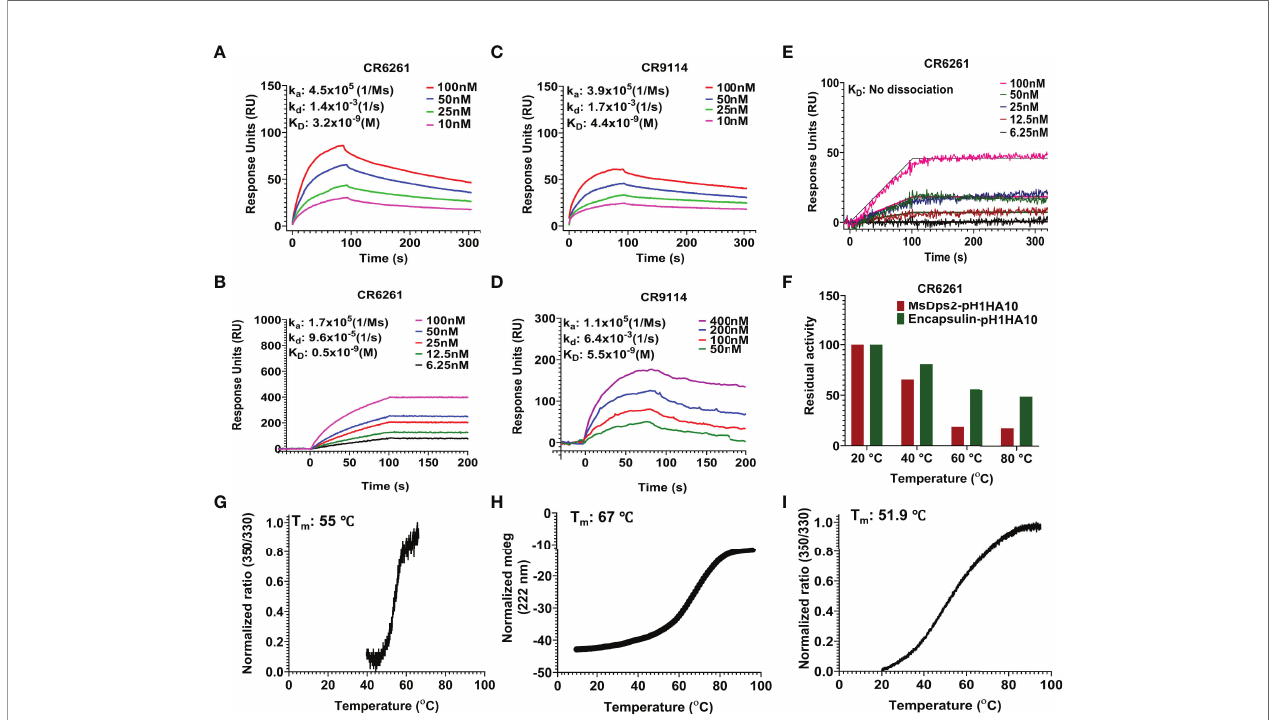
FIGURE 3 | SPR studies and thermal stability of pH1HA10-nanoparticle immunogens. (A – D) SPR binding studies of MsDps2-pH1HA10 (top) and Encapsulin- pH1HA10 (bottom) with CR6261 (A, B) or CR9114 (C, D) . (E) SPR binding of pH1HA10-Ferritin with CR6261. (F) Thermal tolerance of MsDps2- pH1HA10 and Encapsulin- pH1HA10. Proteins were incubated at indicated temperatures for 1h and returned to RT for SPR binding with CR6261. (G) nanoDSF monitored thermal denaturation pro fi le of MsDps2- pH1HA10. (H) CD melt pro fi le of Encapsulin-pH1HA10. (I) nanoDSF monitored thermal melt of pH1HA10-Ferritin.